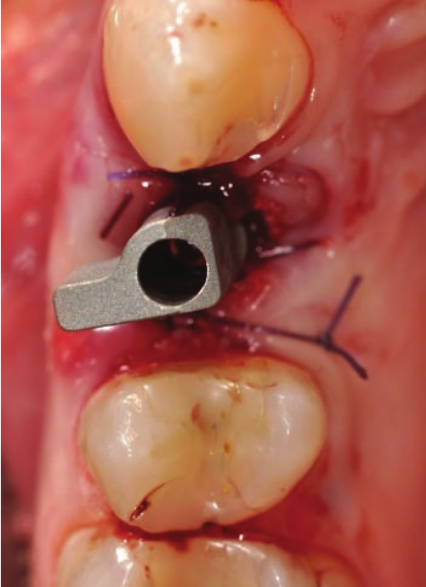
Figure 7: Screwing of the scan abutment, needful to take a scanning with MHT 3D Progress intraoral scanner. Occlusal view.